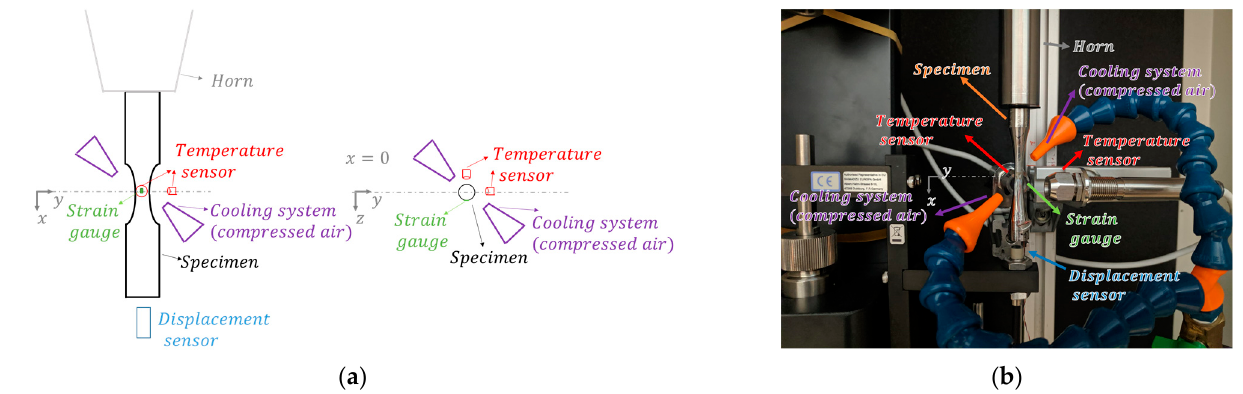
Figure 7. Experimental setup for UHCF testing and measuring systems: ( a ) Schematic view of experimental apparatus; ( b ) Experimental apparatus, in-situ.